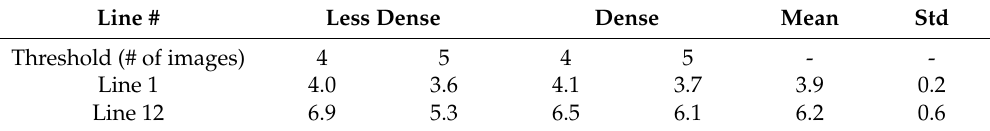
Table 6. Elevation differences between the derived power lines and the ground truth in RMSE (cm). Line # Less Dense Dense Mean Std Threshold (# of